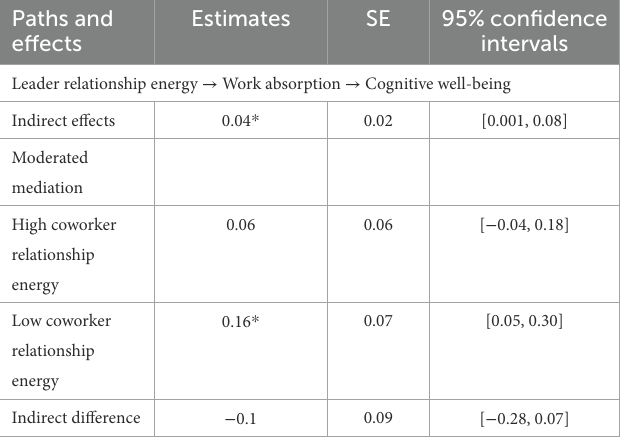
TABLE 5 Summary of indirect effects and conditional indirect effects. Paths and effects